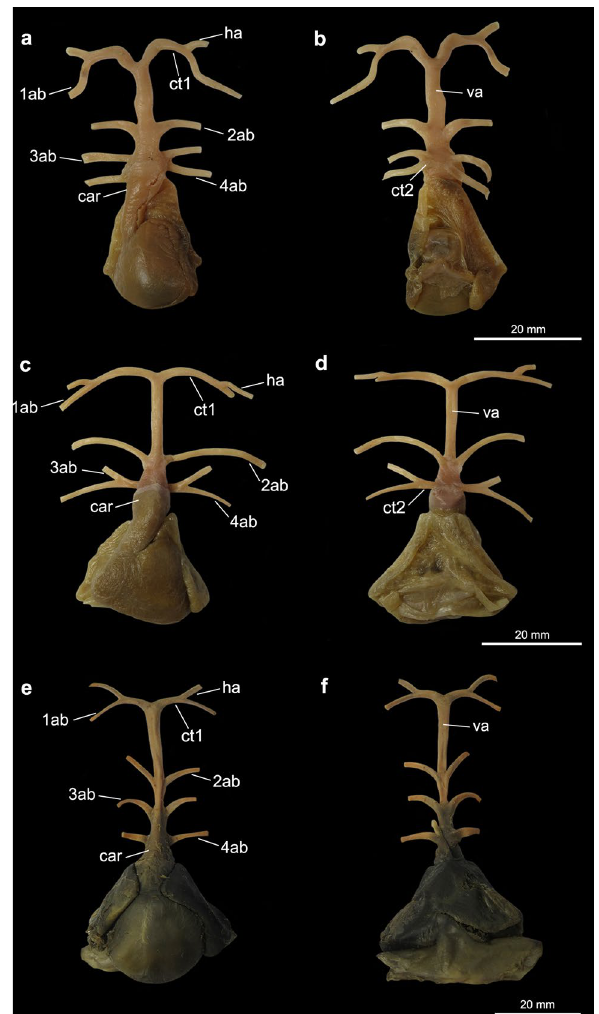
Figure 7. Heart and afferent branchial arteries in shark specimens. ( a ) Ventral and ( b ) dorsal views of Squalus sp.; ( c ) ventral and ( d ) dorsal views of Squatina occulta ; ( e ) ventral and ( f ) dorsal views of Negaprion brevirostris .